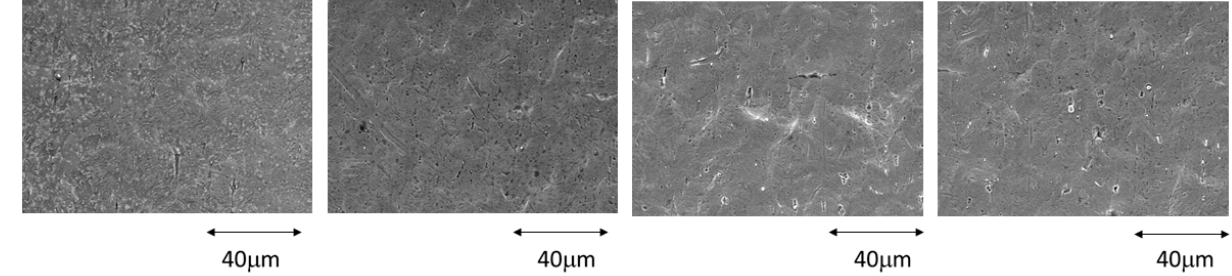
Figure 5. NiTi surfaces after 1, 4, 7, and 14 days immersed in a 380 ppm fluoride solution.